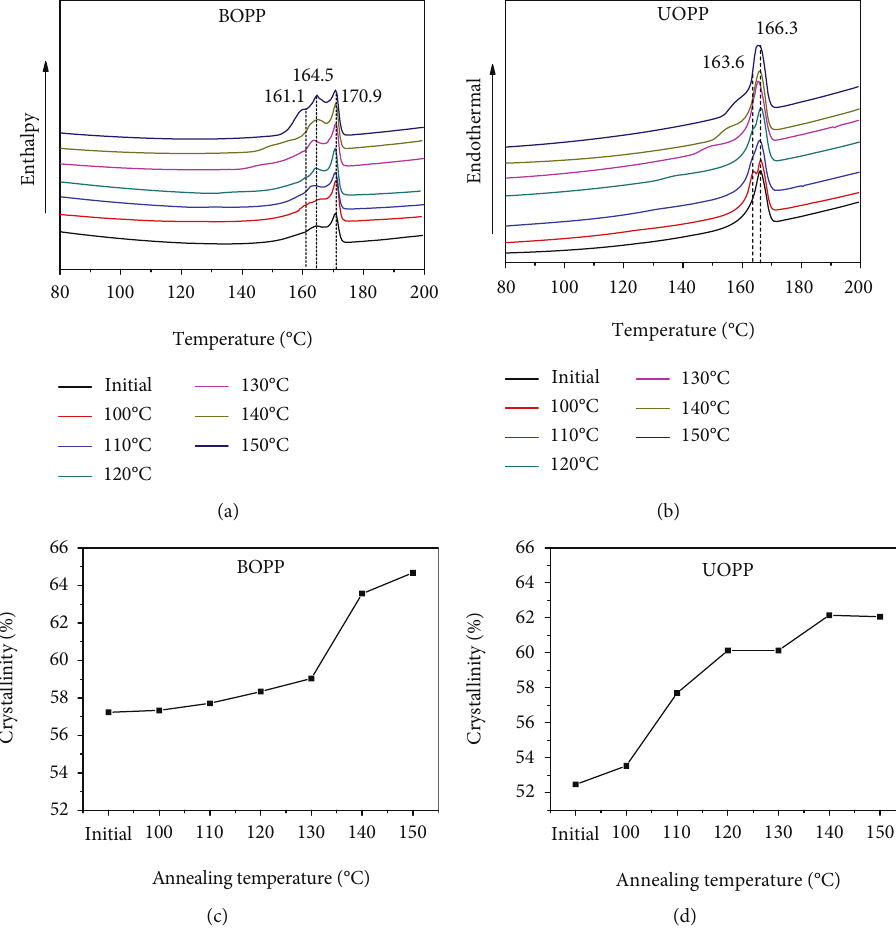
Figure 3: DSC heating curves and crystallinity of PP fi lms. DSC heating curves of (a) BOPP fi lms and (b) UOPP fi lms. Crystallinity of (c) BOPP fi lms and (d) UOPP fi lms ( Δ H 0 = 165J g − 1 f